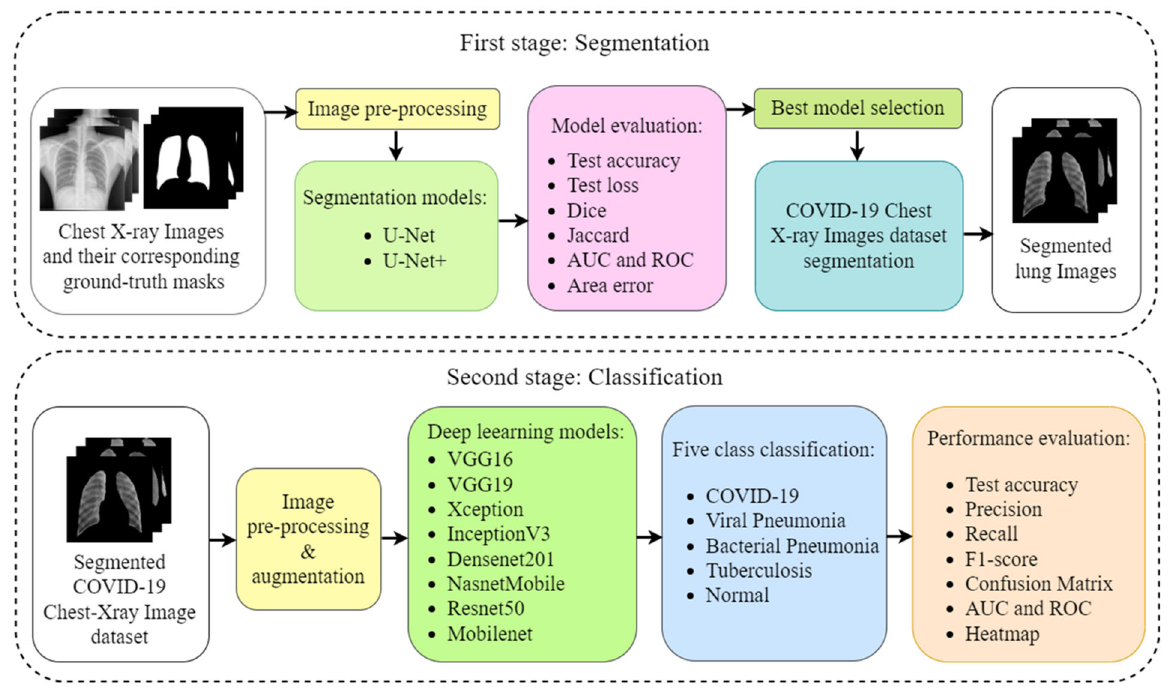
Figure 1. The step ‐ wise overall schematic diagram for the proposed method. (ROC: receiver oper ‐ Figure 1. The step-wise overall schematic diagram for the proposed method. (ROC: receiver operating ating characteristics, AUC: area under curve, VGG: Visual geometry group). characteristics, AUC: area under curve, VGG: Visual geometry group).